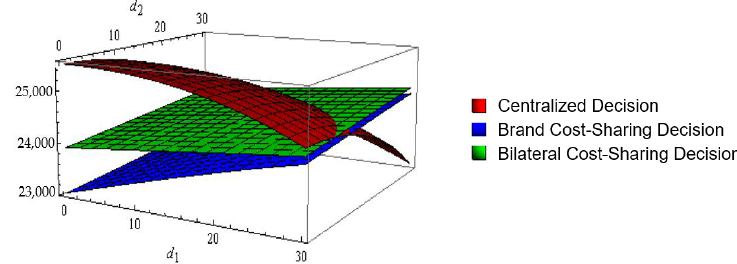
Figure 2. Impact of Time Delay on the Supply Chain Profit.